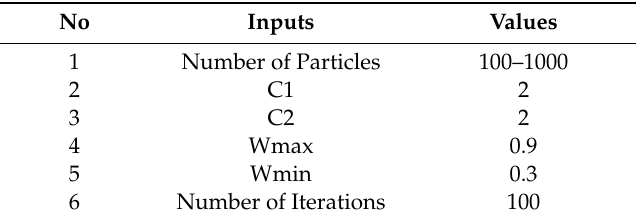
Table 6. PPSO inputs.